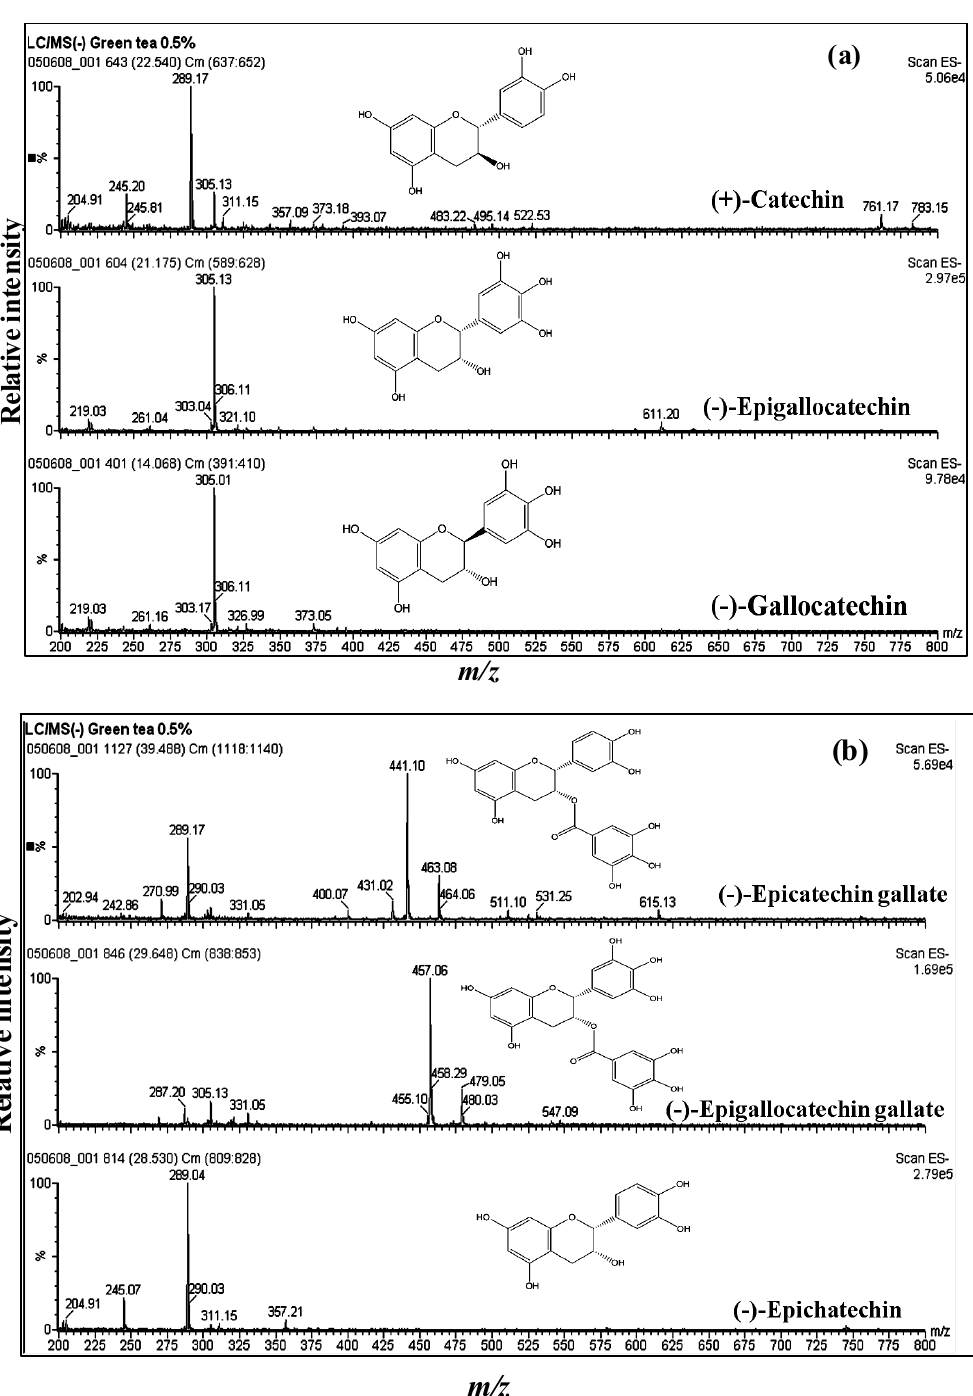
Figure 2. Mass spectra of catechins. ( a ) Catechin with [M − H] – of m/z 289, epigallocatechin with [M − H] – of m/z 305 and gallocatechin with [M − H] – of m/z 305; ( b ) epicatechin gallate with [M − H] – of m/z 441, epigallocatechin gallate with [M − H] – of m/z 457 and epicatechin with [M − H] – of m/z